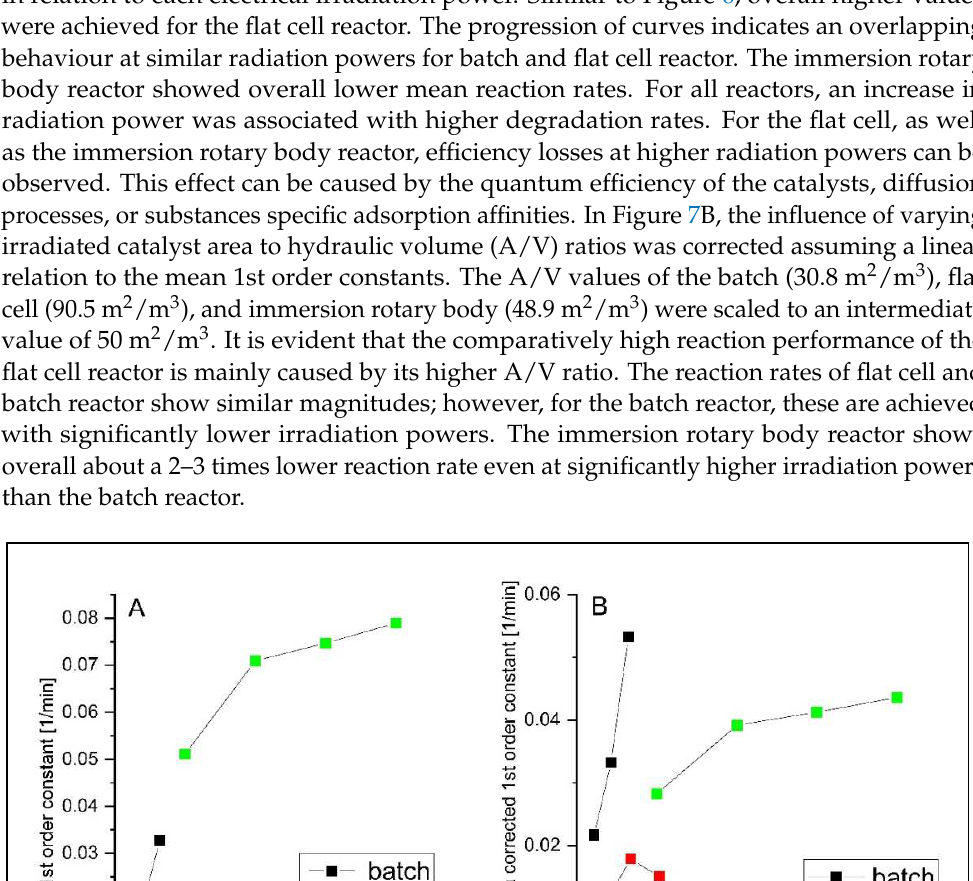
Figure 8. Calculated EE/O value for the photocatalytic oxidation of all micro-pollutants within all three reactor systems at a radiation power of 9.2–14.8 kW/m³.